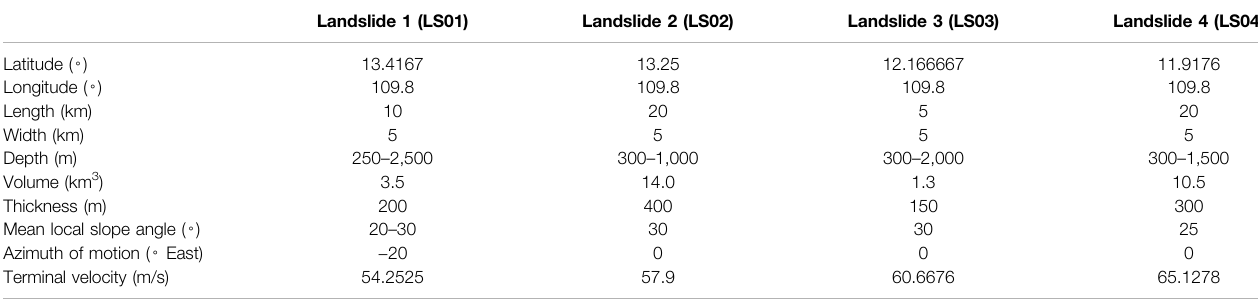
TABLE 1 | Key parameters of submarine landslides.